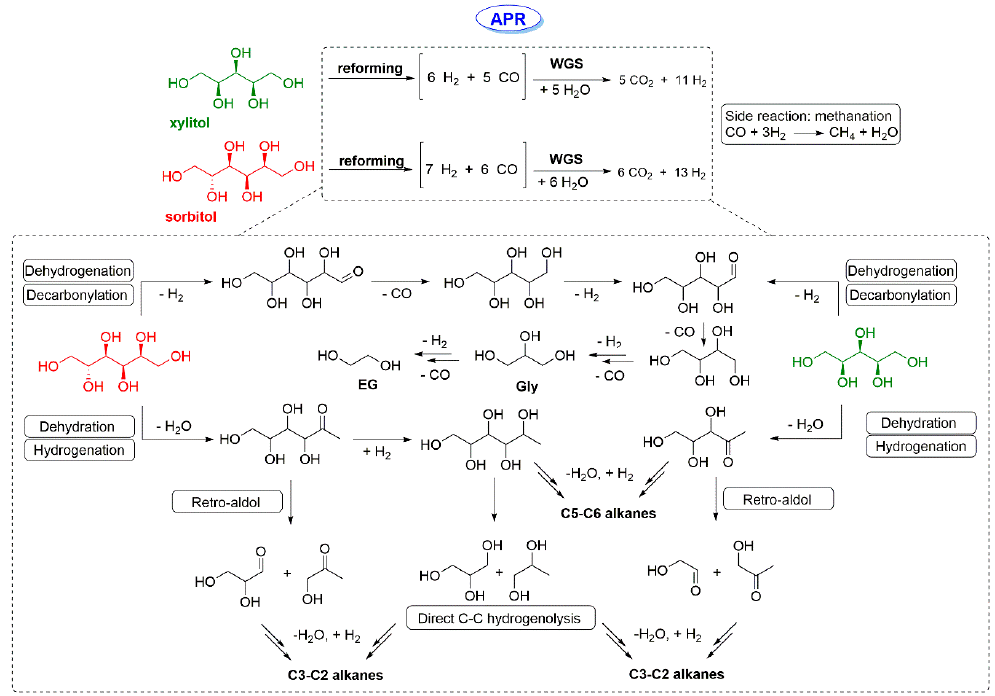
Figure 2. Trend of the peer review manuscripts contain “X aqueous phase reforming” (with X